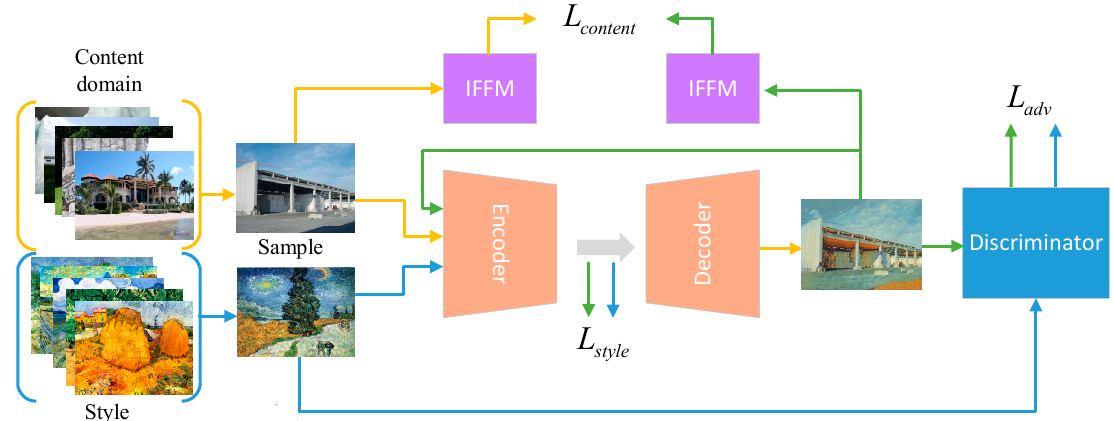
Figure 2. Network architecture.